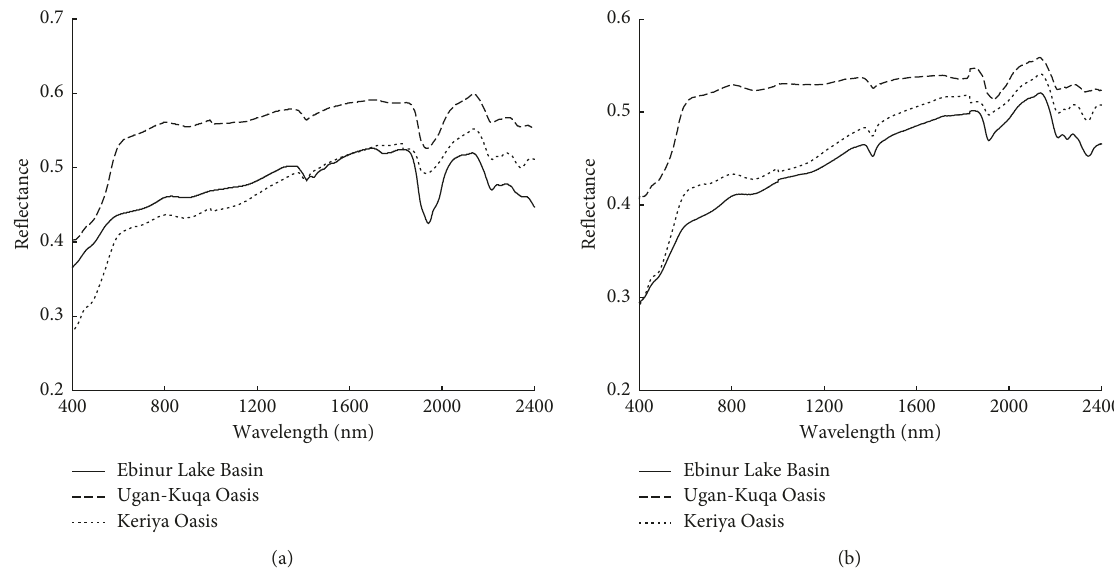
Figure 2: Diffuse reflectance spectra of soil in different areas. (a) Mean reflectance spectra curve of the three regions. (b) Mean reflectance spectra curve of the three regions with SSC (0g · kg − 1